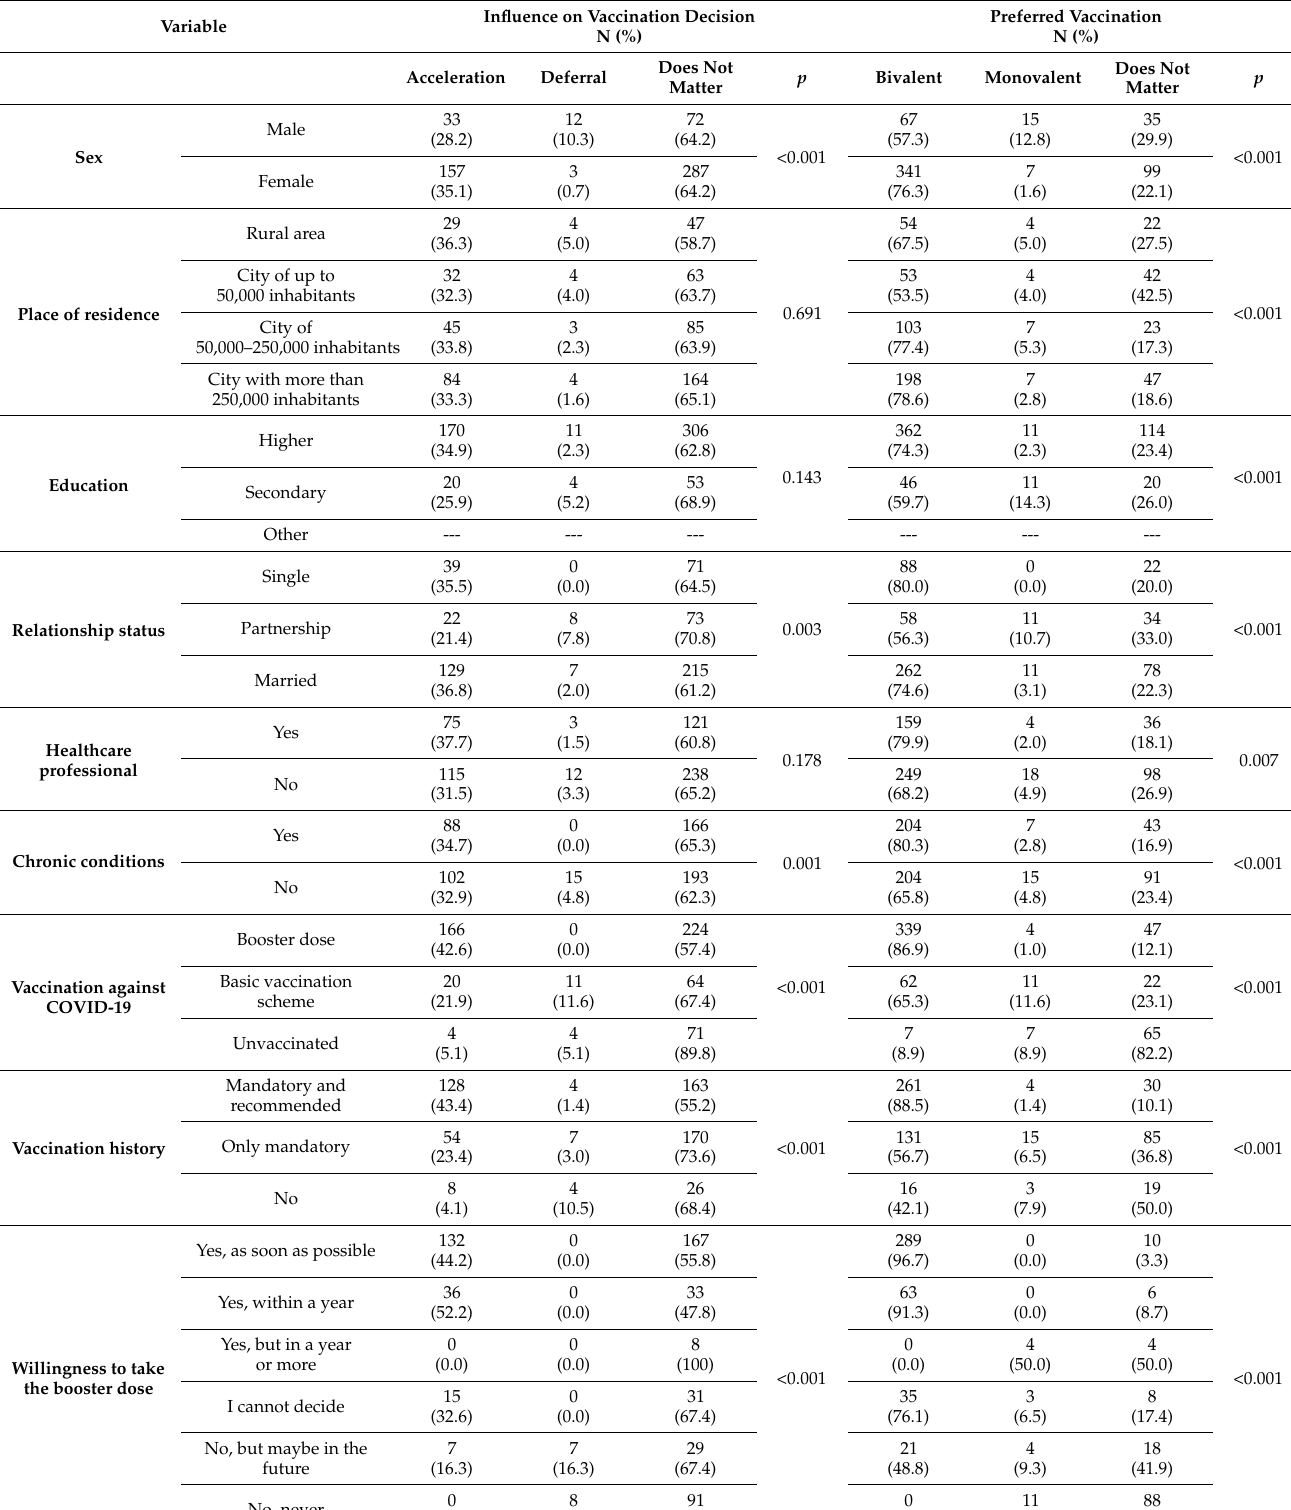
Table 3. Comparison of responses to questions assessing the impact of bivalent formulations on accelerating the decision to vaccinate, along with the preferred type of vaccine in relation to sociode- mographic variables and previous vaccination